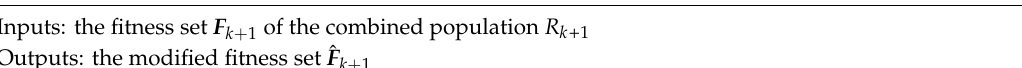
Algorithm 3 Individual-based evolution control